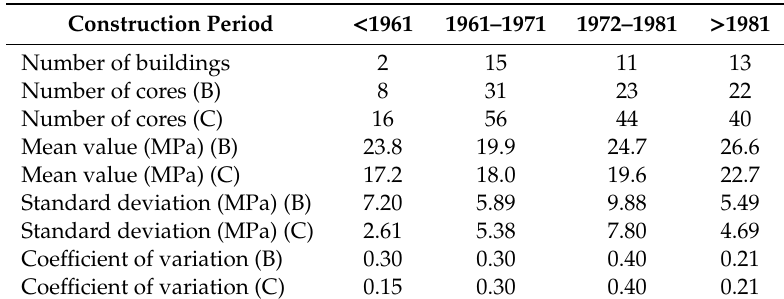
Table 2. Statistical data of the subset of concrete strength values regarding buildings with cores extracted from beams and columns (B = beams, C = columns).